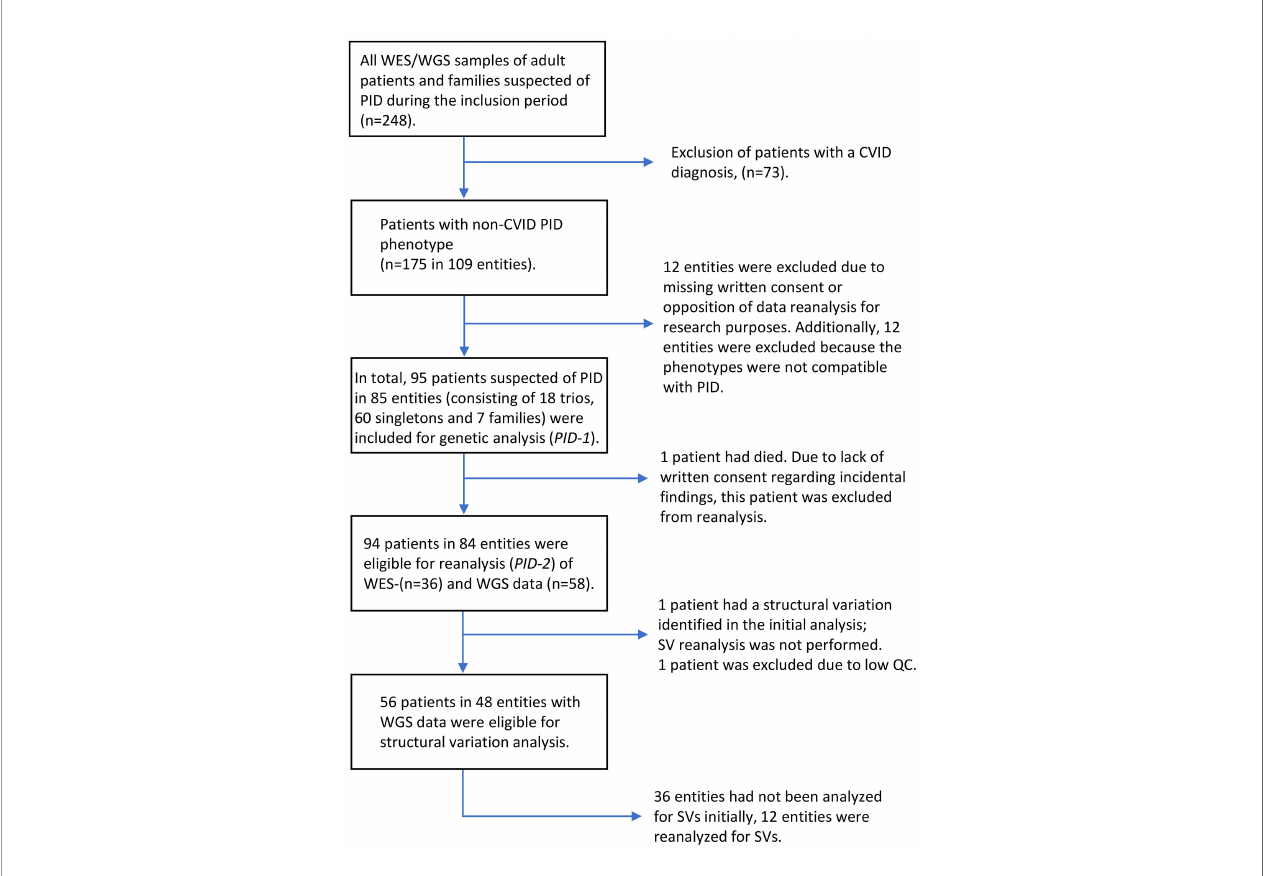
FIGURE 1 | Flowchart of patient